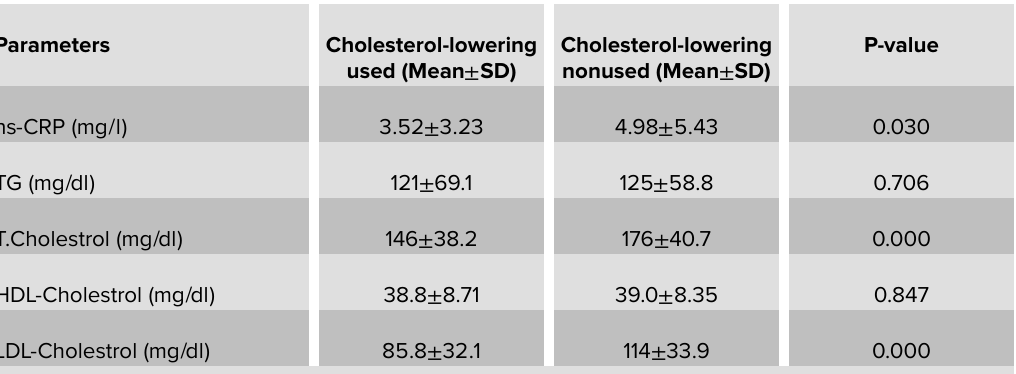
Table 4: Compersion of study parameters in the patient groups classified according to intake of cholesterol- lowering agent.